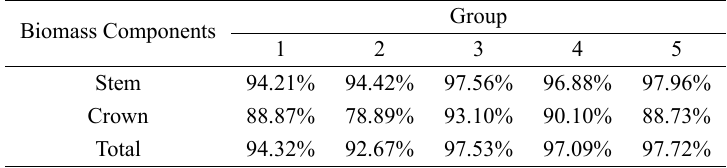
Pearson correlation between the total biomass and of the components with stem volume in stands of black wattle in the state of Rio Grande do Sul, Brazil. Biomass